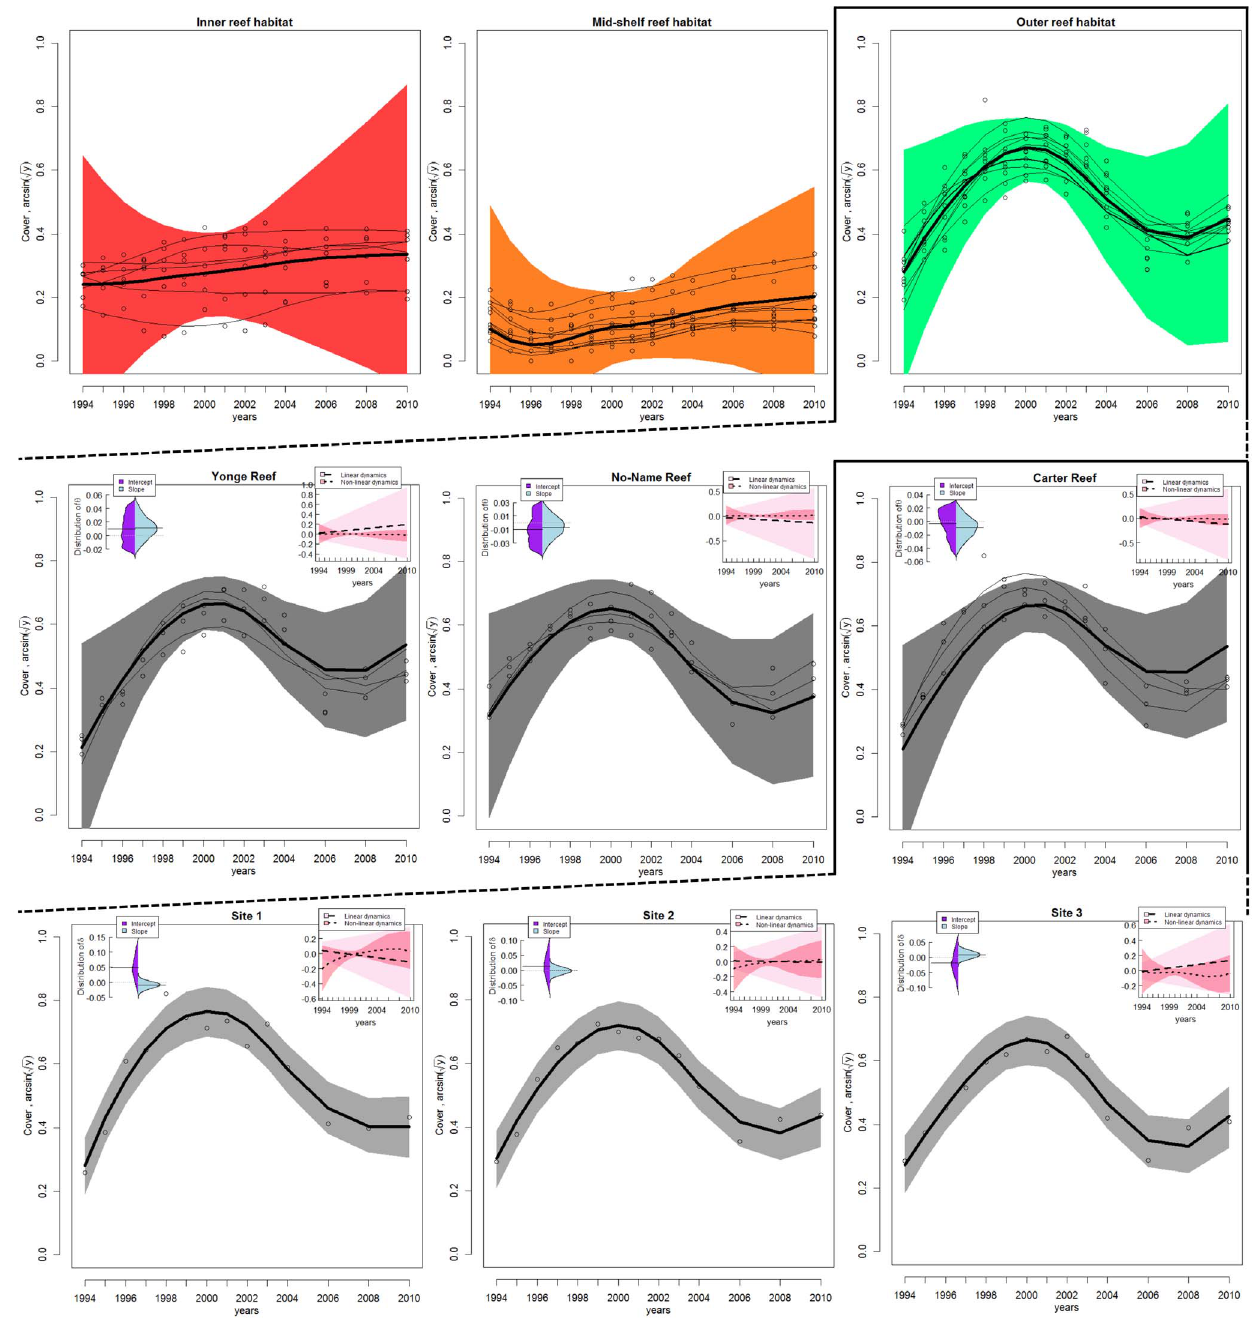
Figure 3. Observed (dots) and fitted (curves) Acropora dynamics and associated parameter estimates and uncertainties. Coral dynamics are modelled at the three spatial scales within the sub-region of Cooktown-Lizard Island; with plotted lines for: habitats (top); reefs (middle); and sites (bottom). Shaded areas encompass 95% posterior predictive intervals around estimated coral trajectories and 95% credible intervals around model parameters. Top-right inserts on plots illustrate the linear and non-linear components of coral trajectories extracted from equations for f h , f r and f i . Top-left inserts illustrate posterior distributions of linear parameters (from the top to the bottom, plotted lines are for: h 0 and h 1 , d 0 and d 1 respectively; refer to Fig. 2, see equations in main text). Intercept terms were indexed by 0 and slope terms by 1 and shown with their 95% credible interval. Thin black lines on reef- and habitat-scale plots (mid- and top-line) show the fitted dynamics of nested individual sites. Note different y-axis scales in inserted graphs. Estimates of coral cover trajectories are illustrated at the three sites at Carter Reef from the outer reef habitat depicted in Figure 1. doi:10.1371/journal.pone.0110968.g003 studies, however, investigated the effects of different covariates major benefit of Bayesian computation, which resides in its without full consideration of the associated uncertainties in their capacity to simultaneously quantify uncertainties associated with models. As a consequence, these studies have not fully utilized a estimated data, model structure and model parameters. Indeed,